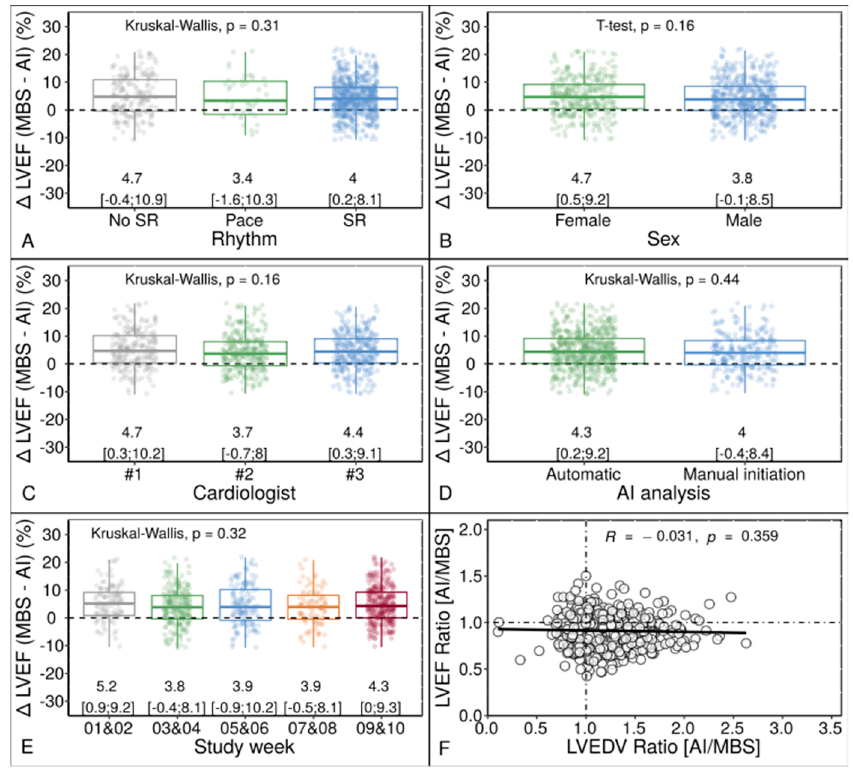
Figure 4. LVEF Bias Grouped by Rhythm ( A ), Sex ( B ), Operator ( C ), Type of AI Analysis ( D ), Study Period ( E ), and by Proportion of EDV Overestimation ( F ) between the AI-based Application and MBS Method ( N = 889). Pace = ventricular pacing; SR = sinus rhythm; Kruskal–Wallis = Kruskal–Wallis test by ranks. Other abbreviations as in Figure 2. Table 5. Reproducibility and Reliability ( N =